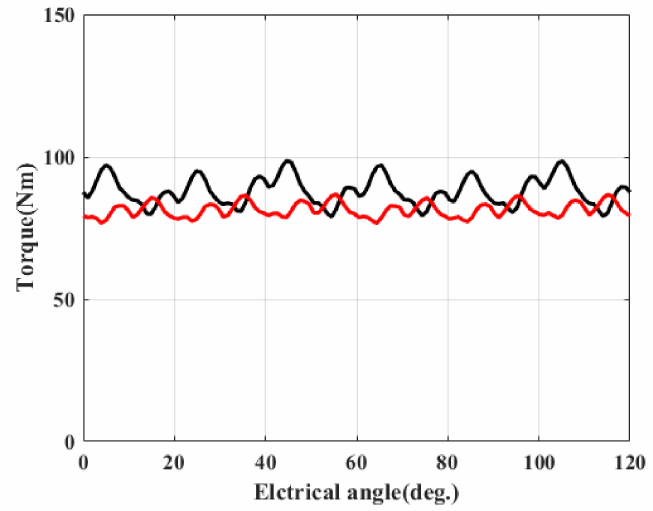
Figure 15. Results of applying the skew to the design model. Black line: the model without skew; red line: the skewed